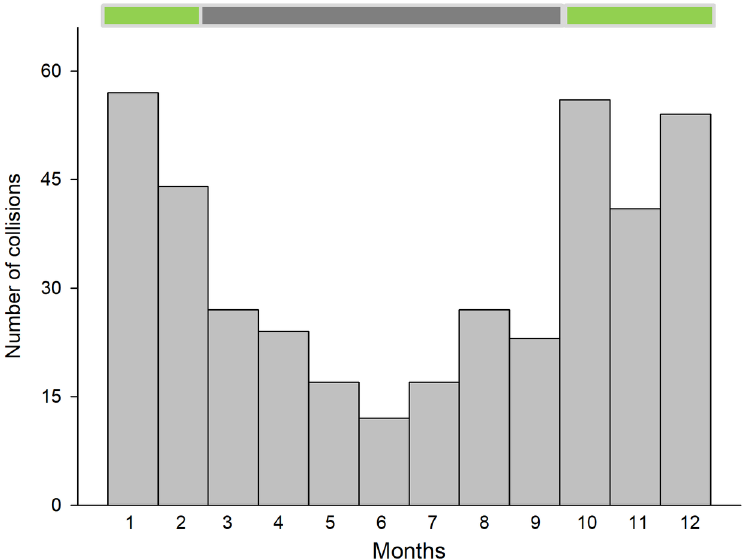
Fig 3. Monthly distribution of dog-vehicle collisions. The horizontal bar above the graph indicates the months with intense (green) and low/no hunting activity (grey).